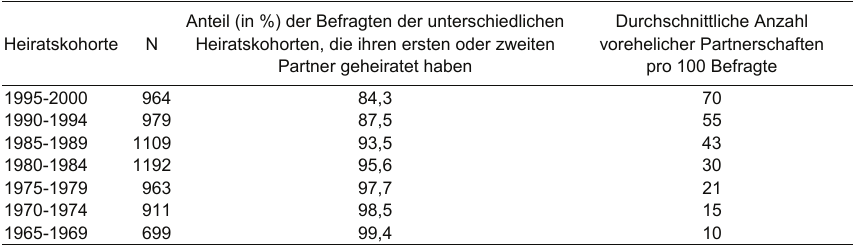
Tab. 1: Voreheliche Partnerschaften nach Heiratskohorten